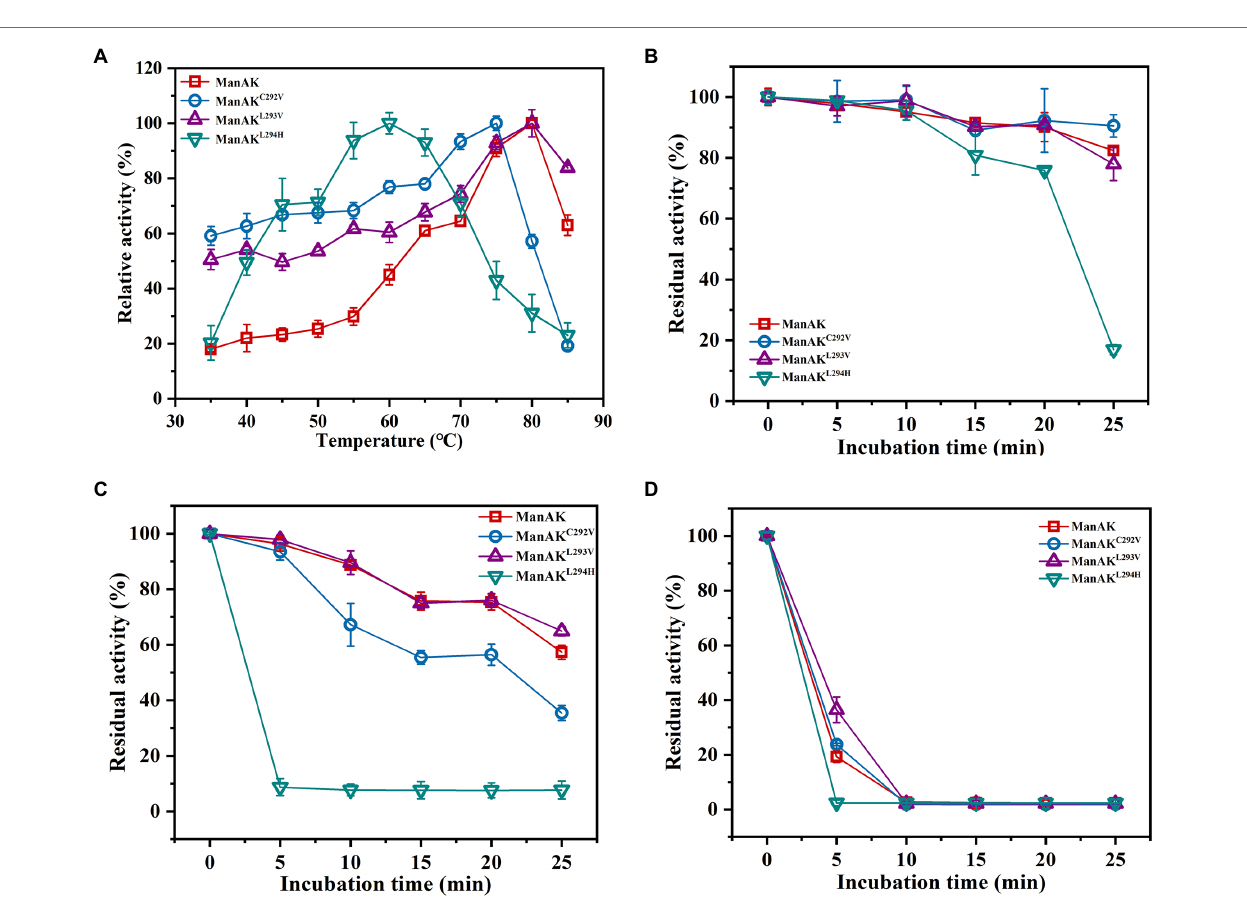
FIGURE 2 | Effects of temperature on activity and stability of recombinant β -mannanases. (A) The optimum temperature was determined in 50 mM sodium acetate buffer (pH 5.5) with a range of 35–85 ° C for 5 min; the thermal stability was evaluated under standard conditions (pH 5.5, 37 ° C, and 30 min) after the enzymes without substrate were treated at 60 (B) , 70 (C) , and 80 ° C (D) for 5–25